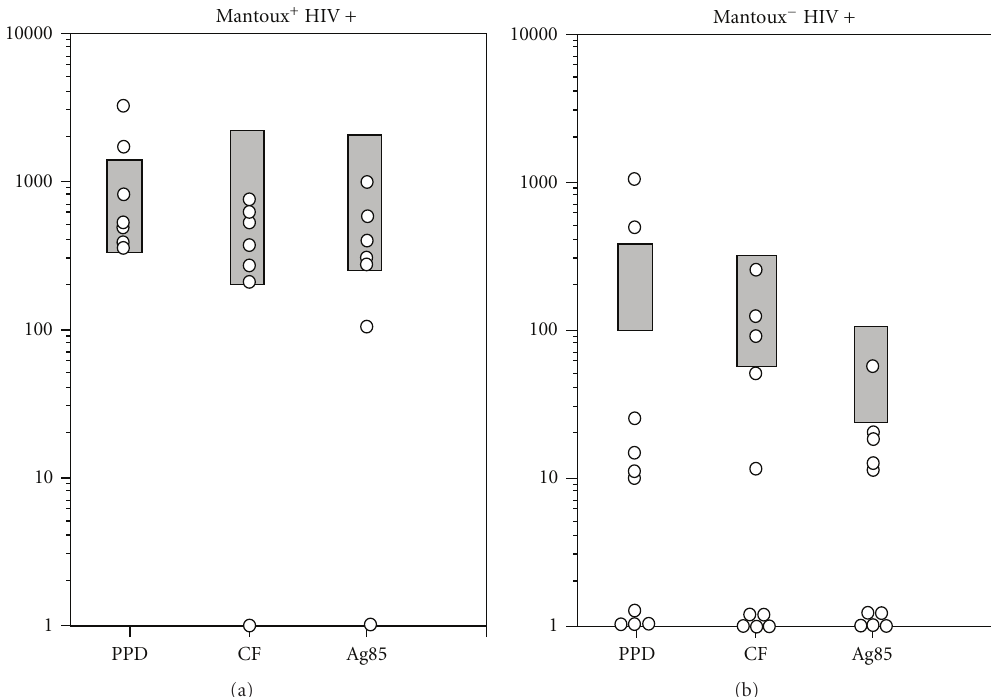
Figure 4: Individual IFN- γ production (pg/mL) in PBMC in response to di ff erent antigens from tuberculin-positive (a) or tuberculin- negative (b) HIV-positive CDC-B subjects su ff ering from varicella zoster and/or candidiasis. A negative response was considered as less than mean − 2SD of the IFN- γ production by PBMC from healthy tuberculin-positive (a) and tuberculin-negative (b) HIV-positive controls. The circle: subjects with varicella zoster and/or candidiasis (category B of the CDC classification). The grey rectangle: mean ± 2SD of the IFN- γ produced by PBMC from tuberculin-positive (a) and tuberculin-negative (b) HIV-positive controls.